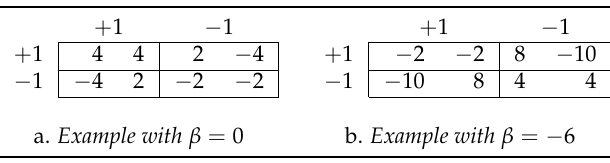
Table 9. Conflicting